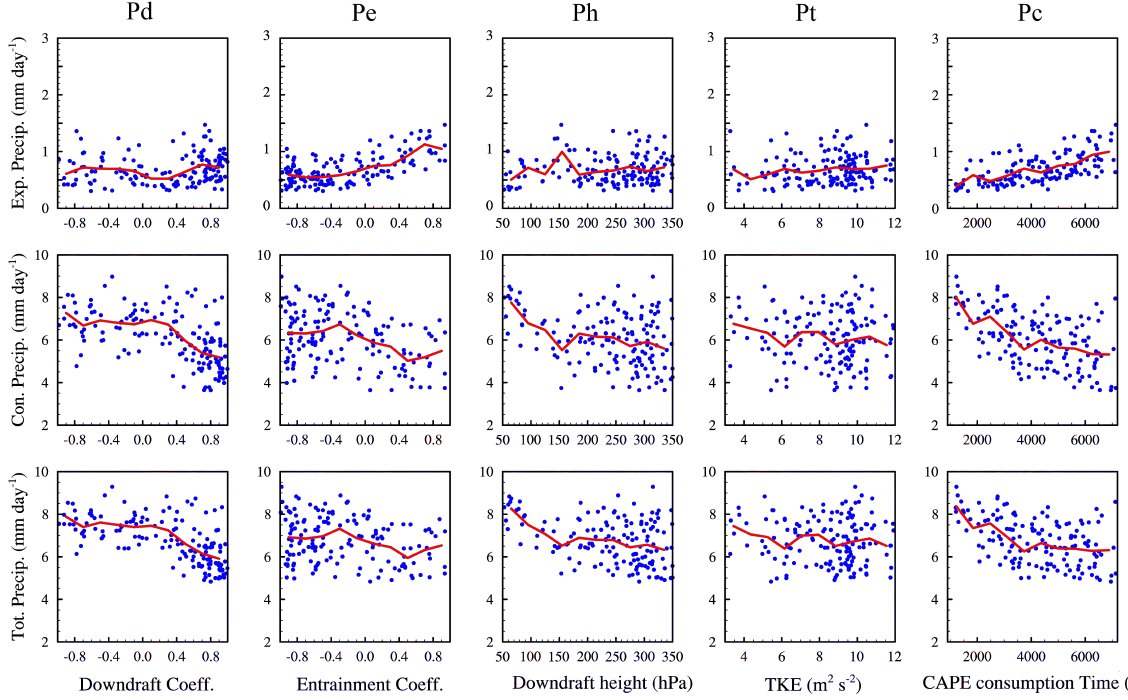
Fig. 7. The response of simulated explicit (top), convective (middle) and total (bottom) precipitation averaged over the sub-domain shown in Fig. 3 to the five parameters in the KF scheme. The meaning of red curves is same as in Fig.